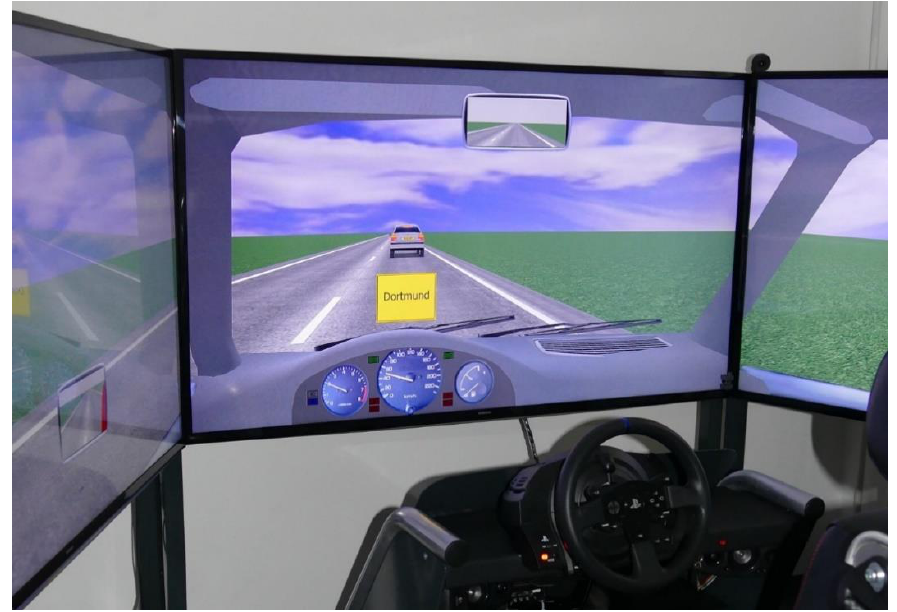
Figure 1. Screenshot of driving simulator task with flashing up brake lights of the leading car and visual distractor.